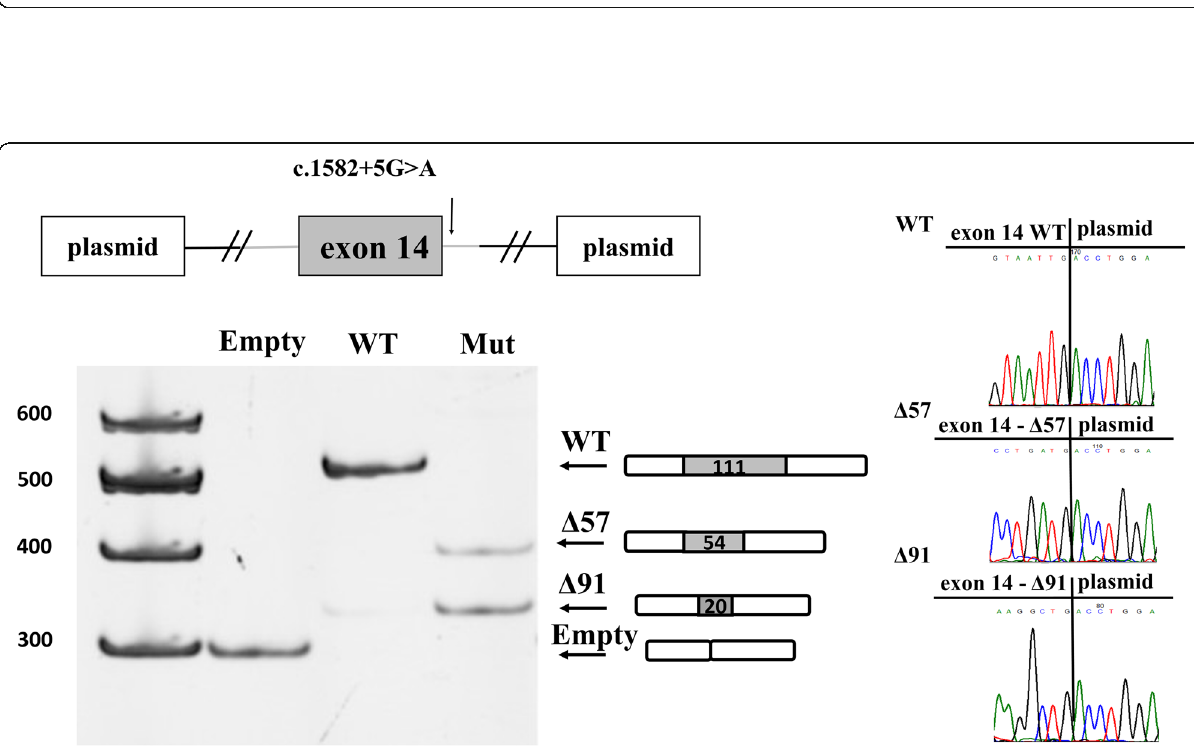
Fig. 1 Left panel shows the pedigree of the affected family. Black symbol indicate affected individual. Black dotes indicated unaffected carriers – the probands parents and the fetus. Right panel shows the electropherograms of the identified variant in the proband and his parents